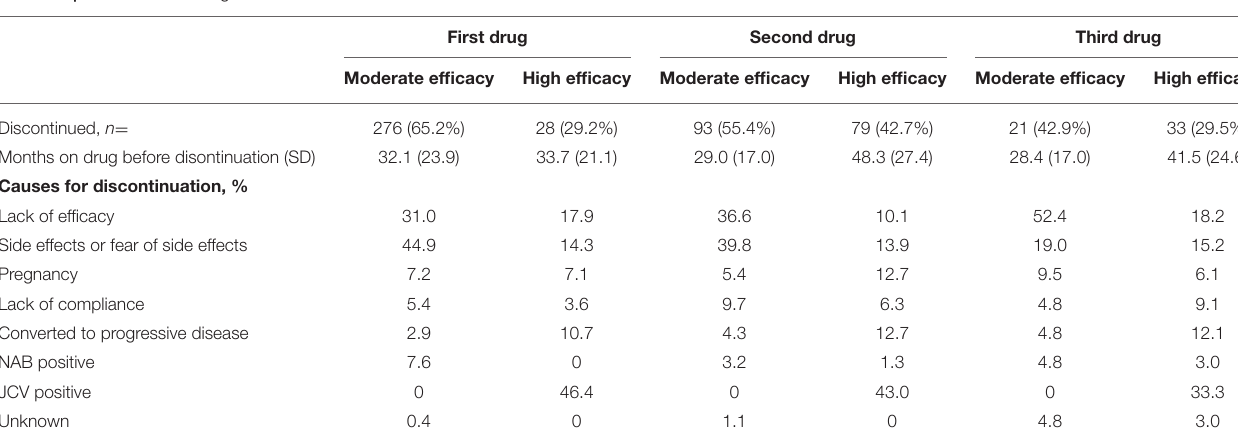
TABLE 8 | Information on drug discontinuation.